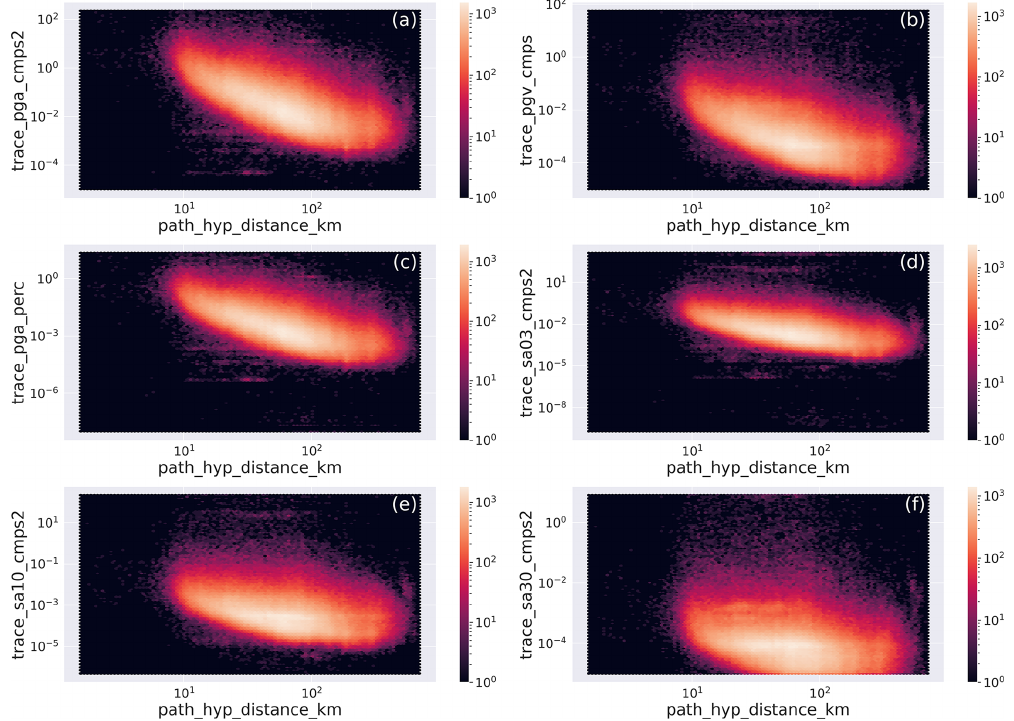
Figure 12. Hexbin plot of the distribution of the intensity measures (IMs) with hypocentral distance of the earthquake dataset for the M ≥ 2 earthquakes. The units are kilometers (km) along the horizontal axis in all panels, and along the vertical axis the units are centimeters per second squared (cms − 2 ) in panels (a) and (d) – (f) , centimeters per second (cms − 1 ) in panel (b) , and percent of the acceleration of gravity (% g ) in panel (c) . The metadata names listed in Table 2 are used as labels for the specific metadata being